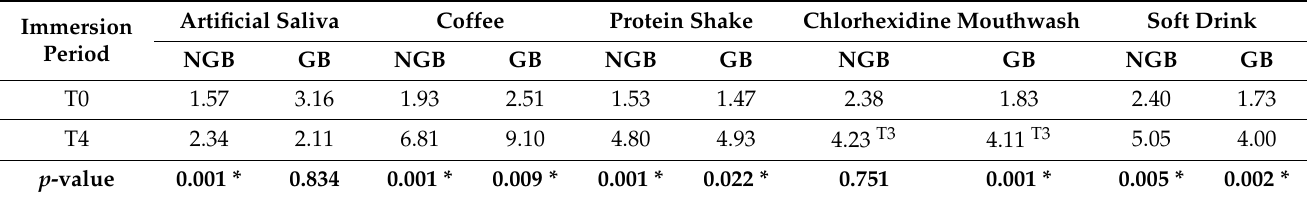
Table 7. Comparison of color change between T0 and T4 for extra translucent group.